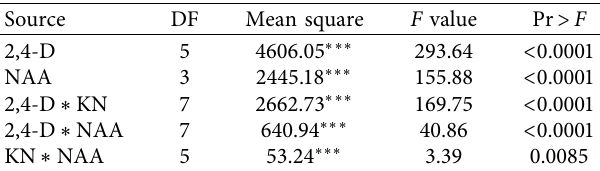
Note: ∗∗∗ � very highly significant, ∗∗ � highly significant, ∗ � significant, and ns � not significant at α � 0.05.